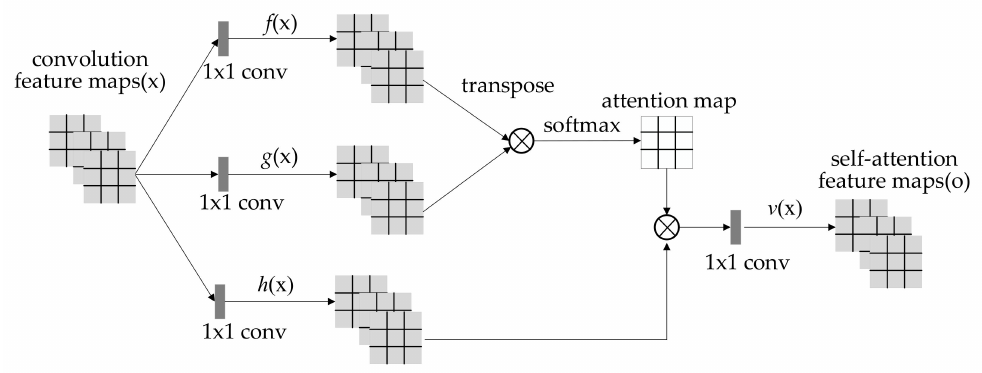
Figure 3. Schematic diagram of the self-attention